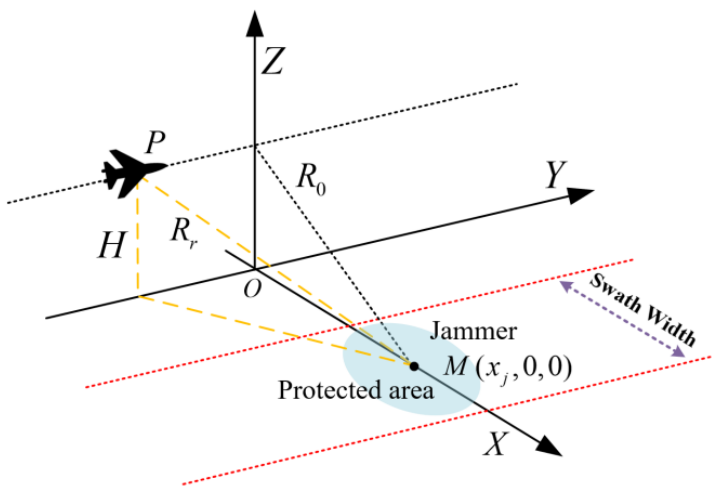
Figure 1. Geometry model of repeater-type jamming.